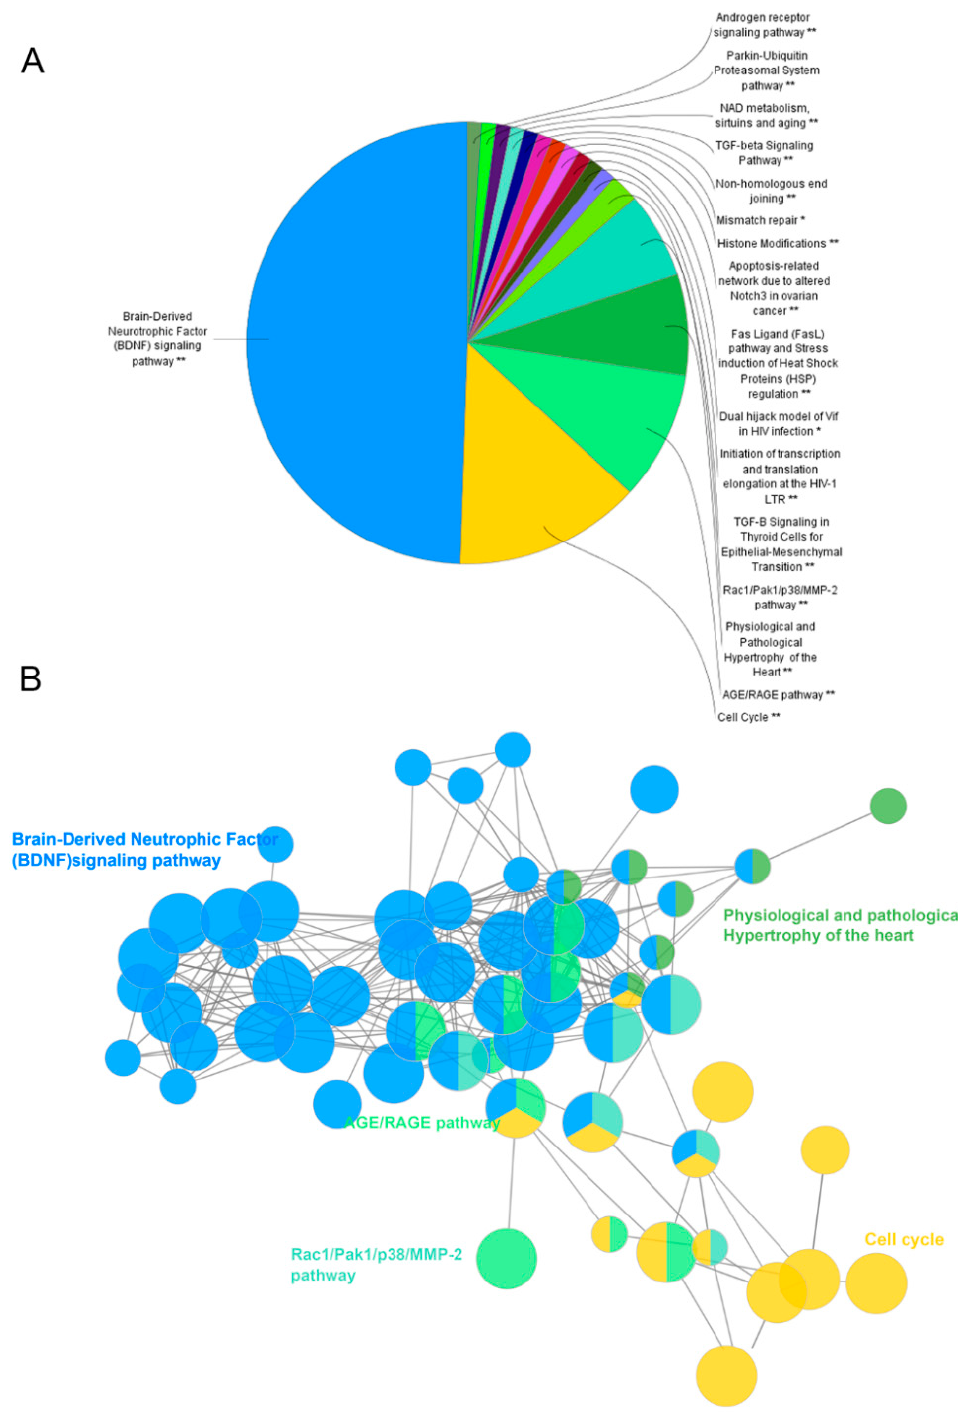
Figure 5. Pathway enrichment analysis. The analysis was conducted by ClueGo. GO terms are represented as nodes, and node size represents the term enrichment significance. Functionally related groups partly overlap. Representative enriched pathway ( p < 0.05) interactions among candidate targets of ZL are shown. ( A , B ) Candidate ZL targets enriched in representative signaling pathways. Representative enriched pathways (* p < 0.05, ** p < 0.01) were shown.